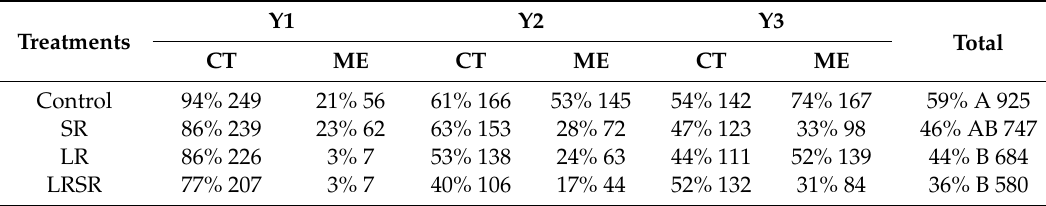
Table 1. Percent survival and number of surviving, unfed, nymphal Ixodes scapularis over three winters in Connecticut (CT) and Maine (ME). Total survival values with the same letter assignment were not significantly di ff erent. For each winter, n = 24 pots for both CT and ME.